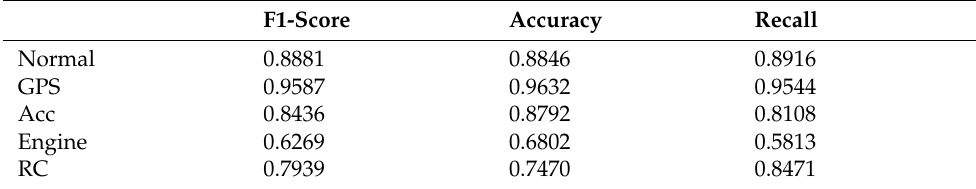
Table 15. Results of GPS